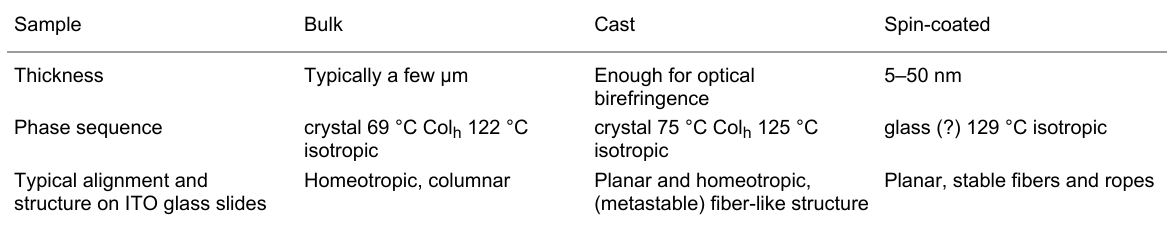
Table 1: Overview of results for the different films compared to bulk samples.